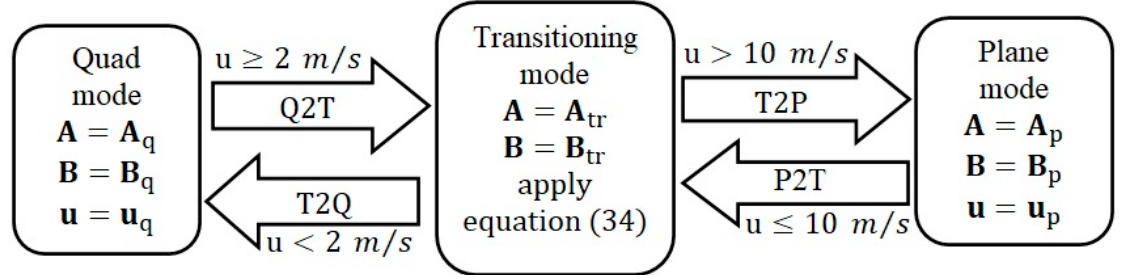
Figure 3. Quadplane gradual transitioning hybrid control system.